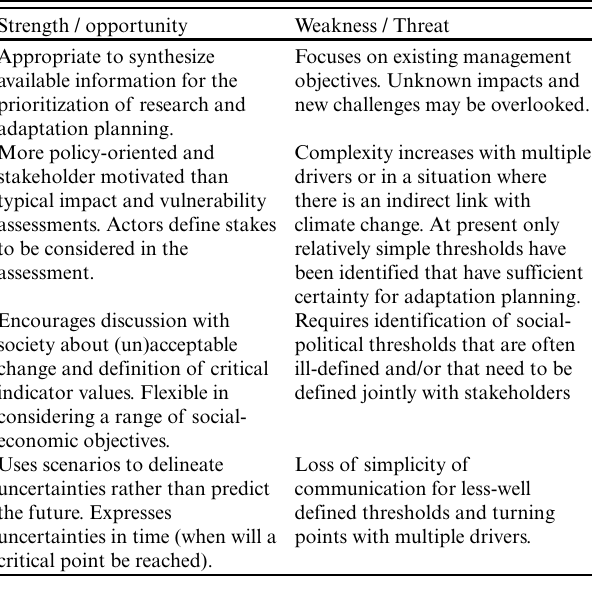
Table 2 . Strengths and weaknesses of the adaptation turning point